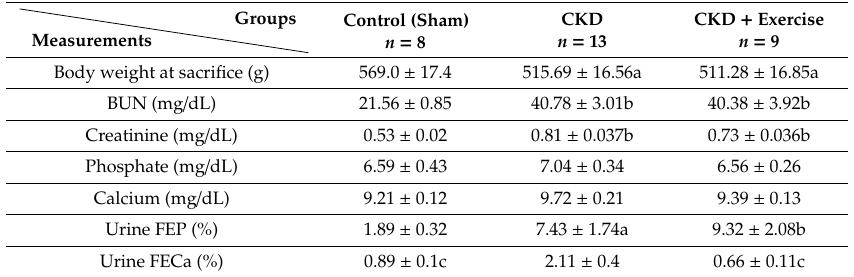
Table 1. Serum and urinary biochemistries of the experimental animals at the time of